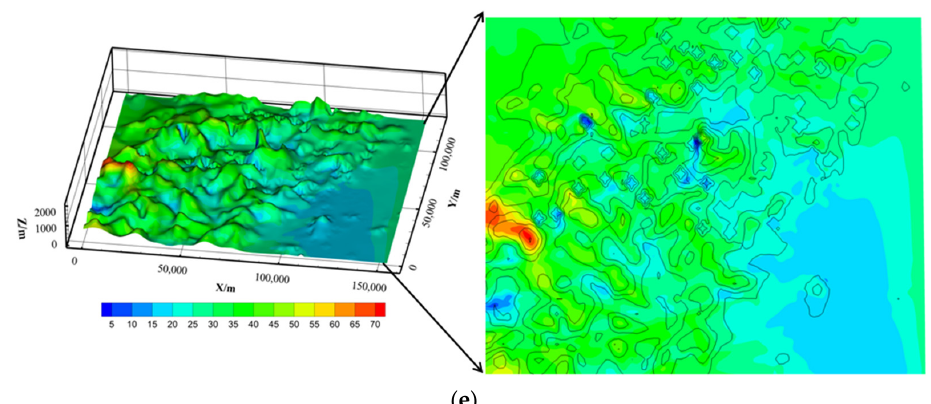
Figure 7. Wind speed contour map plots of five simulation cases: ( a ) Case 1; ( b ) Case 2; ( c ) Case 3; ( d ) Case 4; ( e ) Case 5.